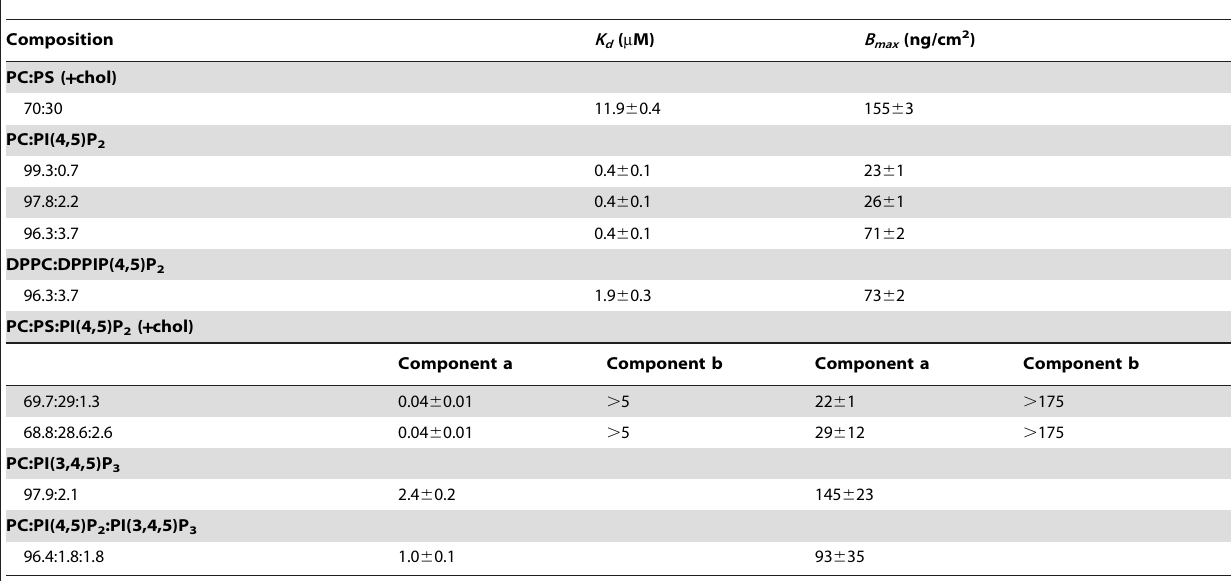
Table 1. Quantification of wt PTEN Binding to stBLMs by SPR.